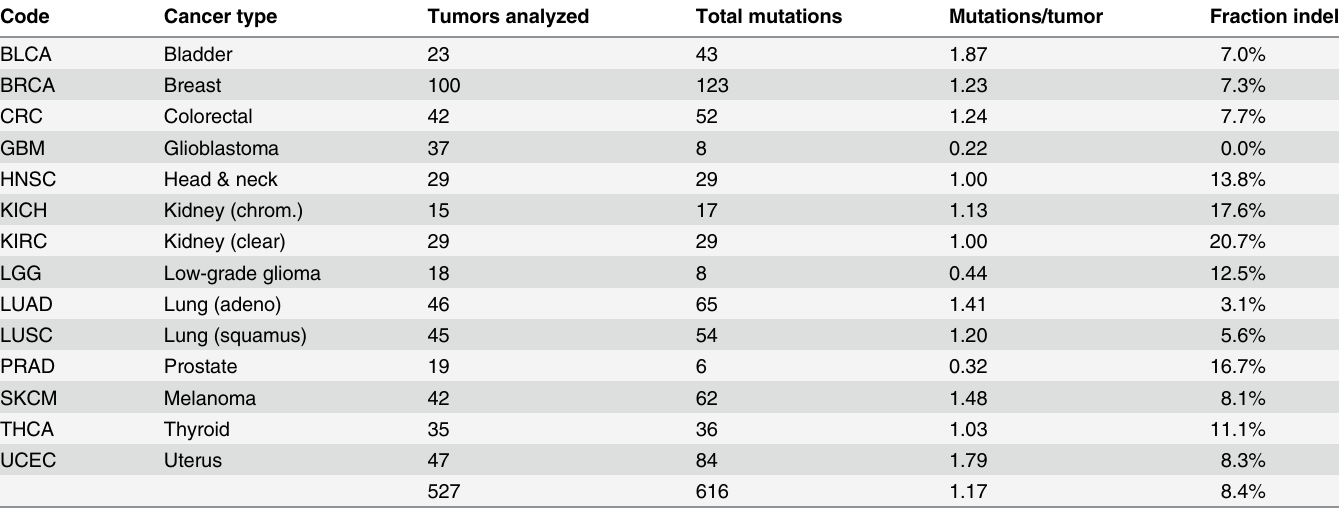
Table 1. Overview of included tumors and detected somatic mtDNA mutations.